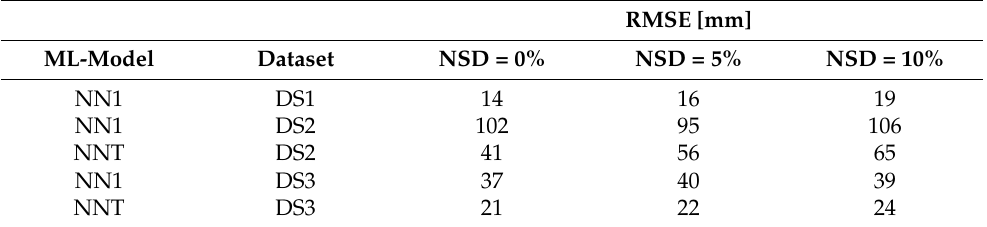
Table 3. Summary of performance of ANNs under different noise standard deviations